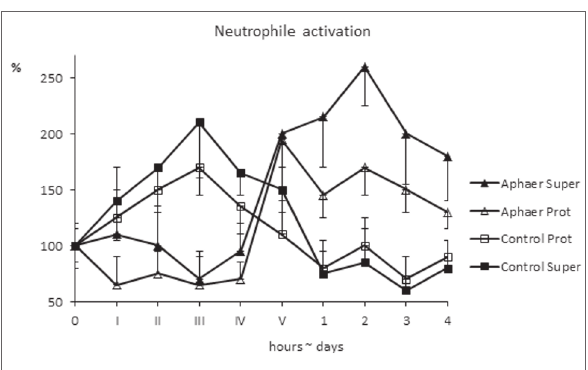
Fig. 1. Neutrophil activation expressed by superoxide anion production and protease activity. 0: before aphaeresis-filtration, i: after aphaeresis-filtration, ii: 10 min. after starting cpB, iii: after stopping cpB, iV: after skin suture, V: 6 h postop. 1-4: postop. days. data are expressed as a percentage of initial anion production and protease activity. P < 0.001 for time point 0 versus point iii. and point 2 by one-way analysis of variance. P < 0.001 for points iii. and 2 by two-way analysis of variance for repeated measurements.